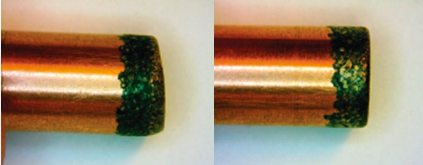
Figure 14: Variation in electrode wear with cut depth in titanium.